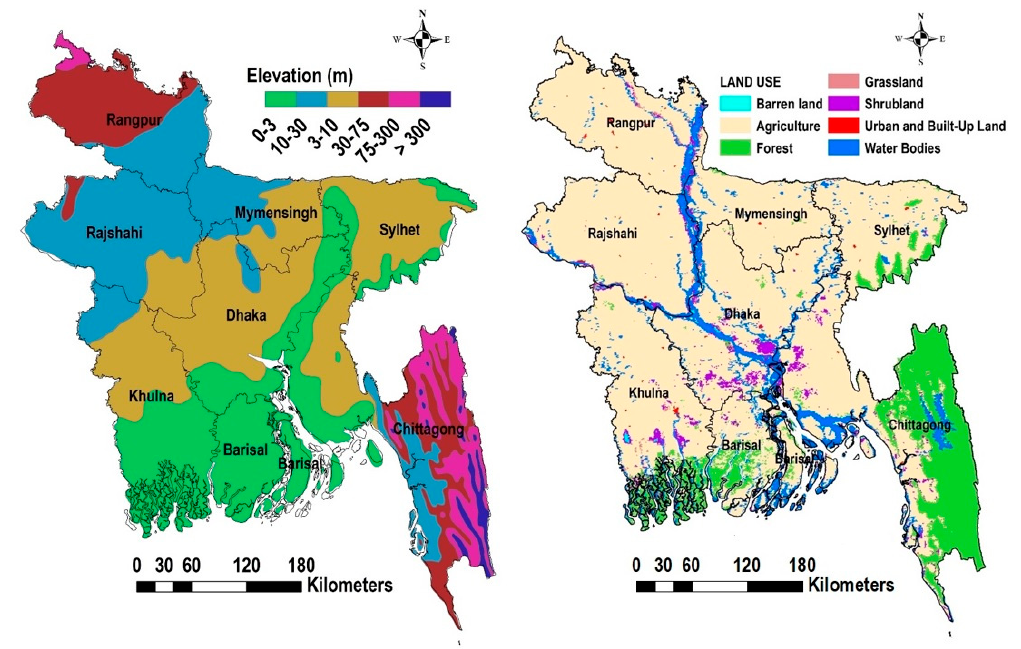
Figure 2. Elevation map ( left ) and land use map ( right ) of Bangladesh.